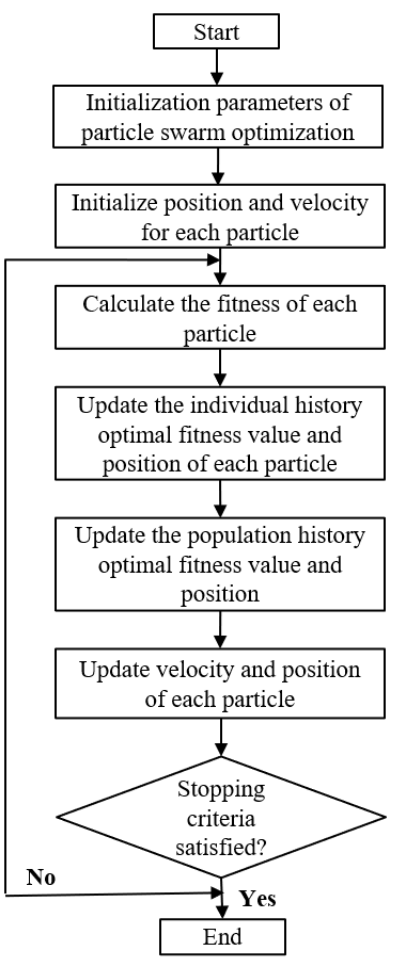
Figure 2. Flow chart of particle swarm